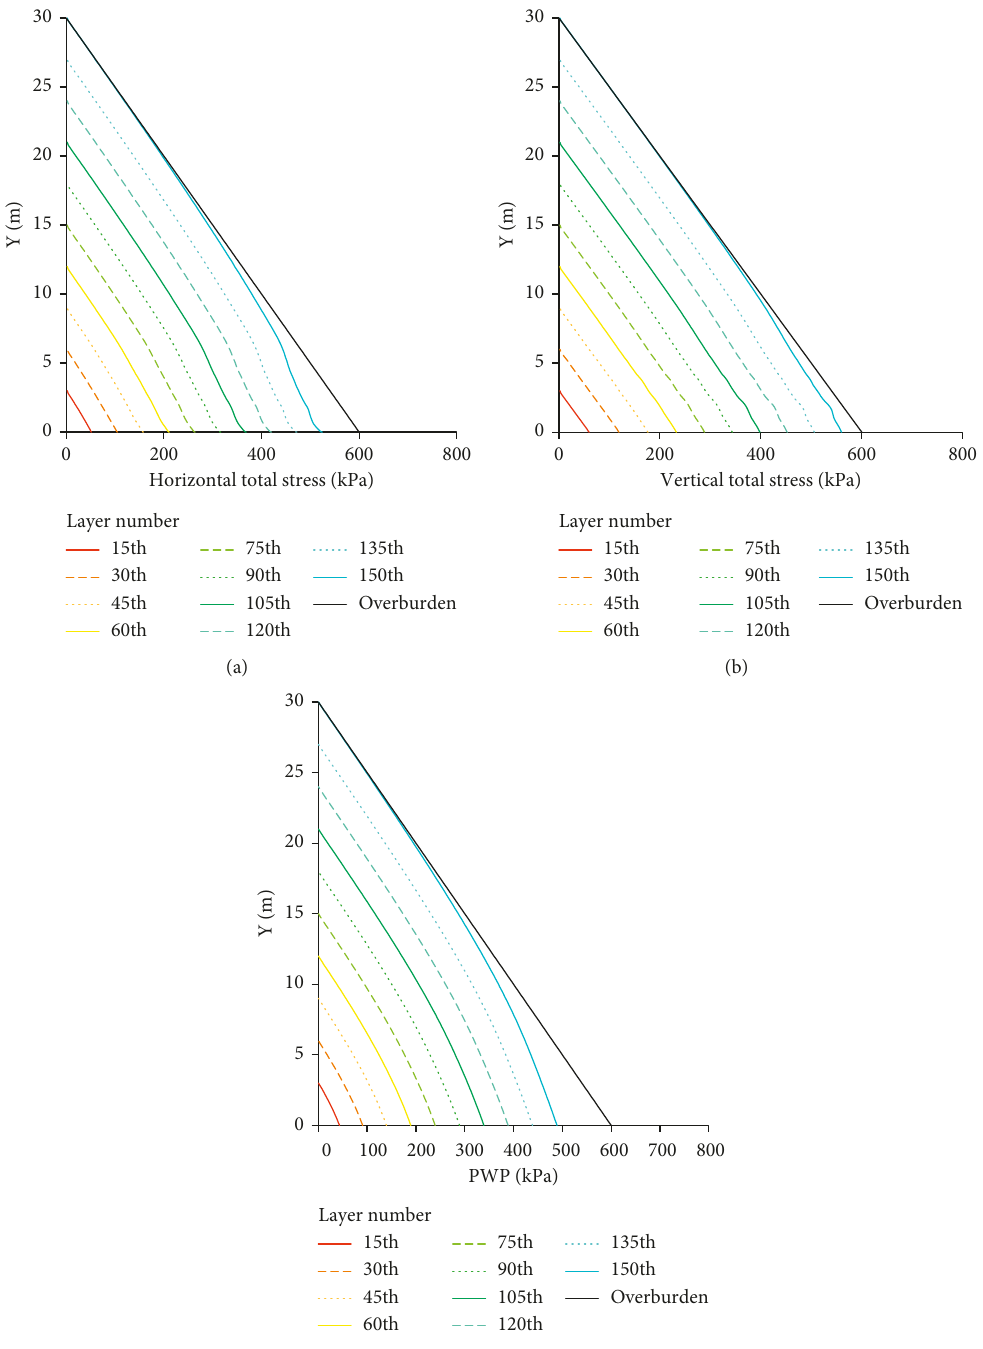
Figure 4: Evolution of the (a) horizontal ( σ h ) and (b) vertical ( σ v ) total stresses and (c) the PWP ( u w ) along the vertical profile (VP) during filling of the stope with 150 layers of backfill (reference case, see details in Table 1, Case